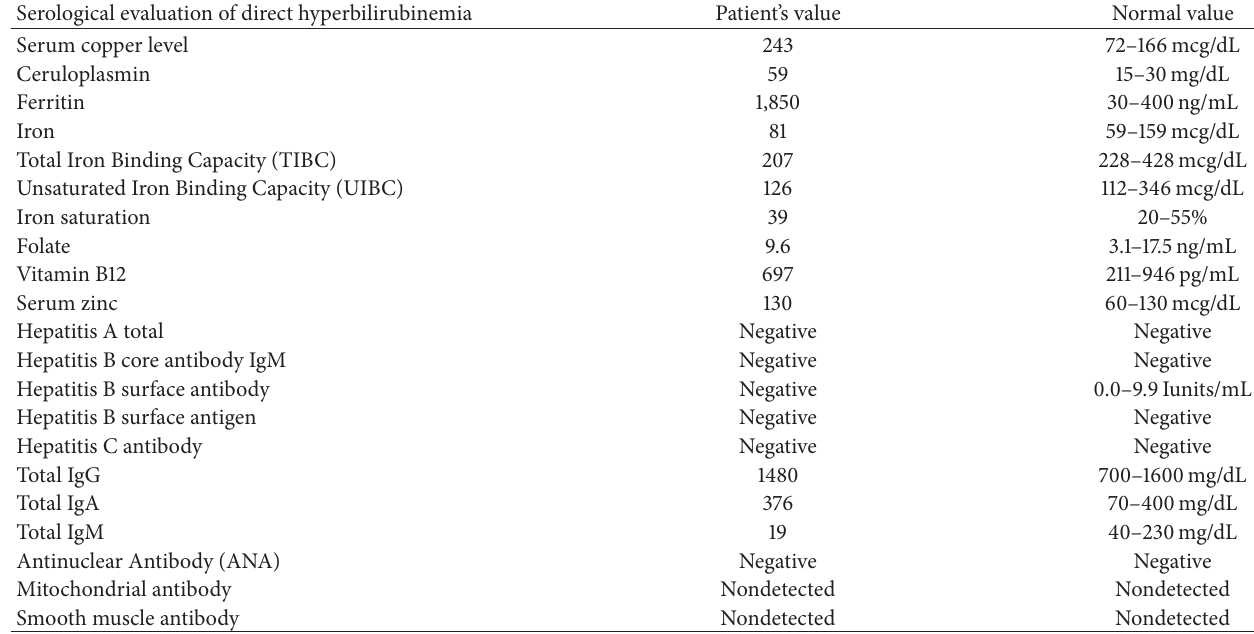
Table 1: Serologic evaluation of elevated direct